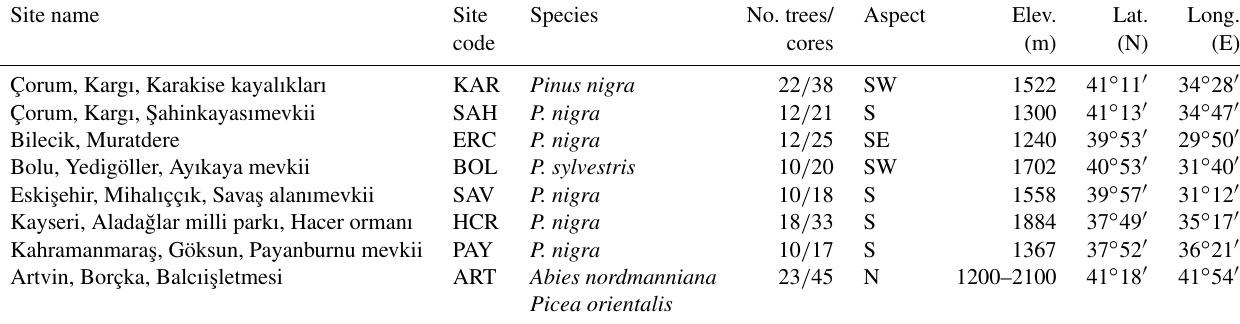
Table 1. Site information for the new chronologies developed by this study in Turkey.